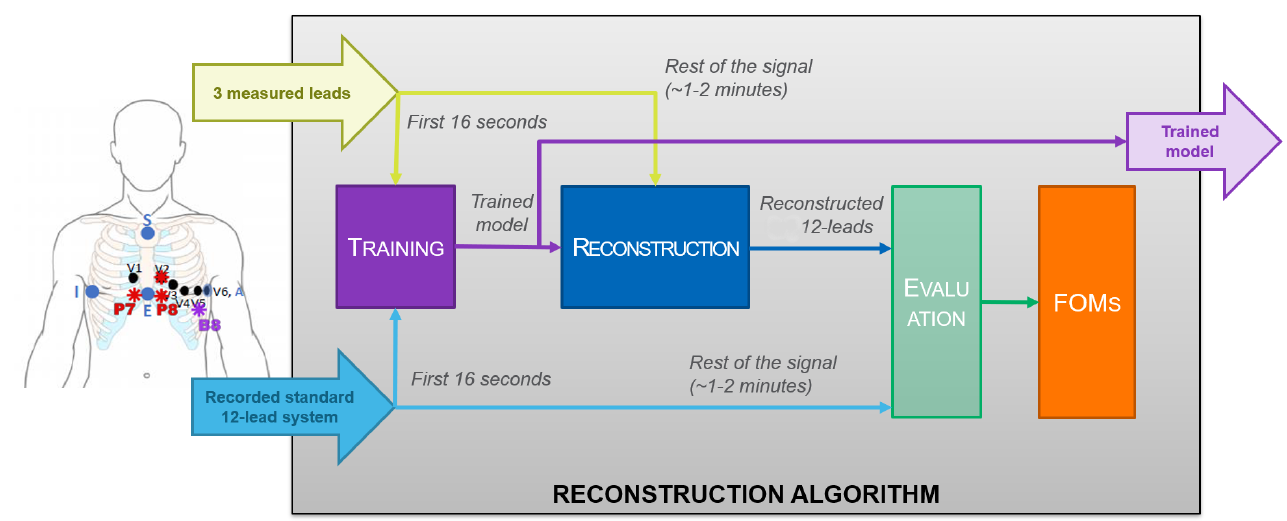
Figure 2. Reconstruction